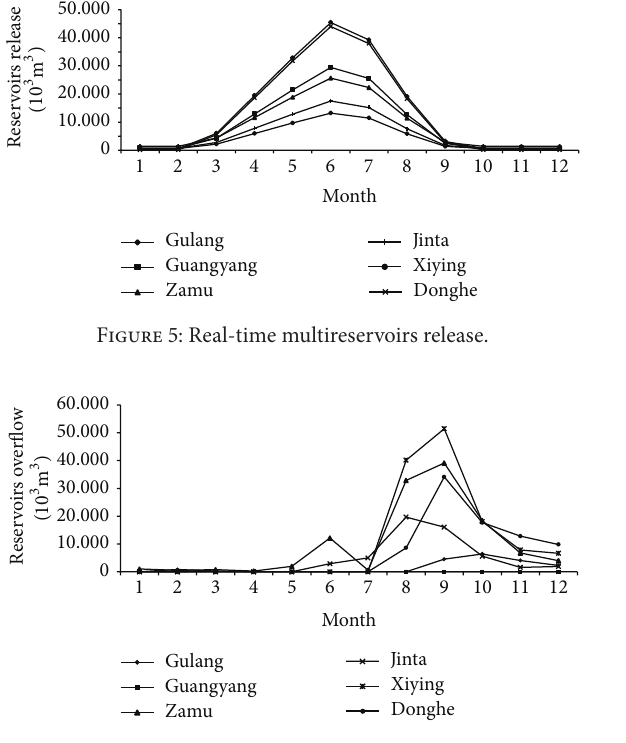
Figure 6: Real-time reservoirs overflow.